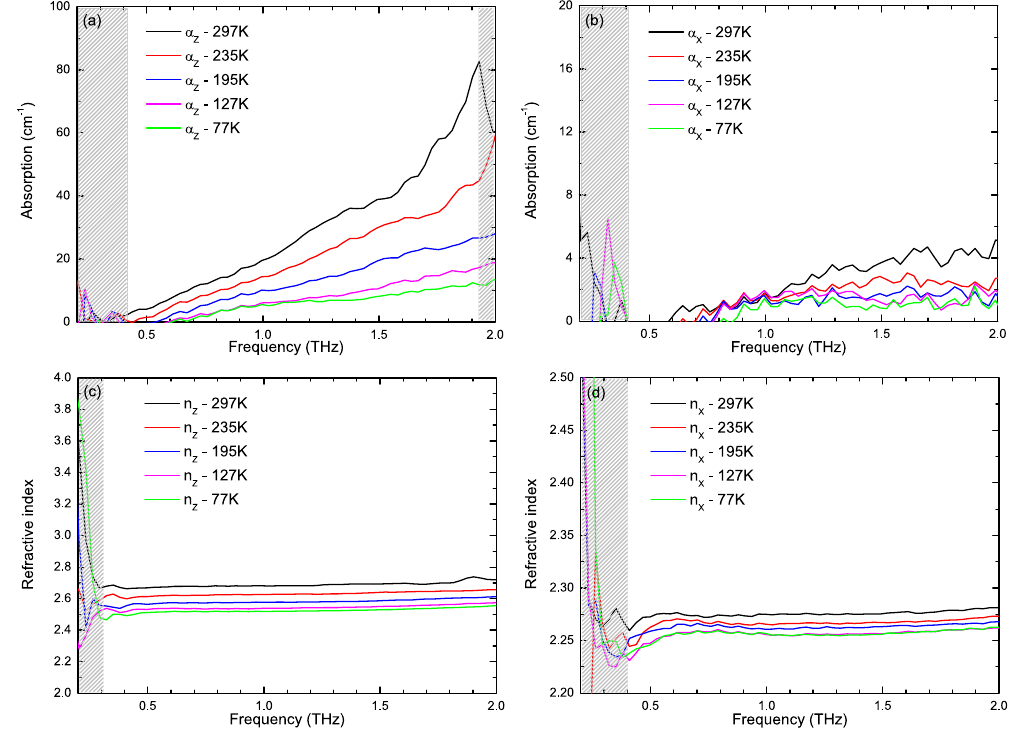
Figure 2. ( a , b ) Measured absorption coefficients α Z and α X from 0.2 to 2.0 THz. ( c , d ) Measured refractive indices n Z and n x from 0.2 to 2.0